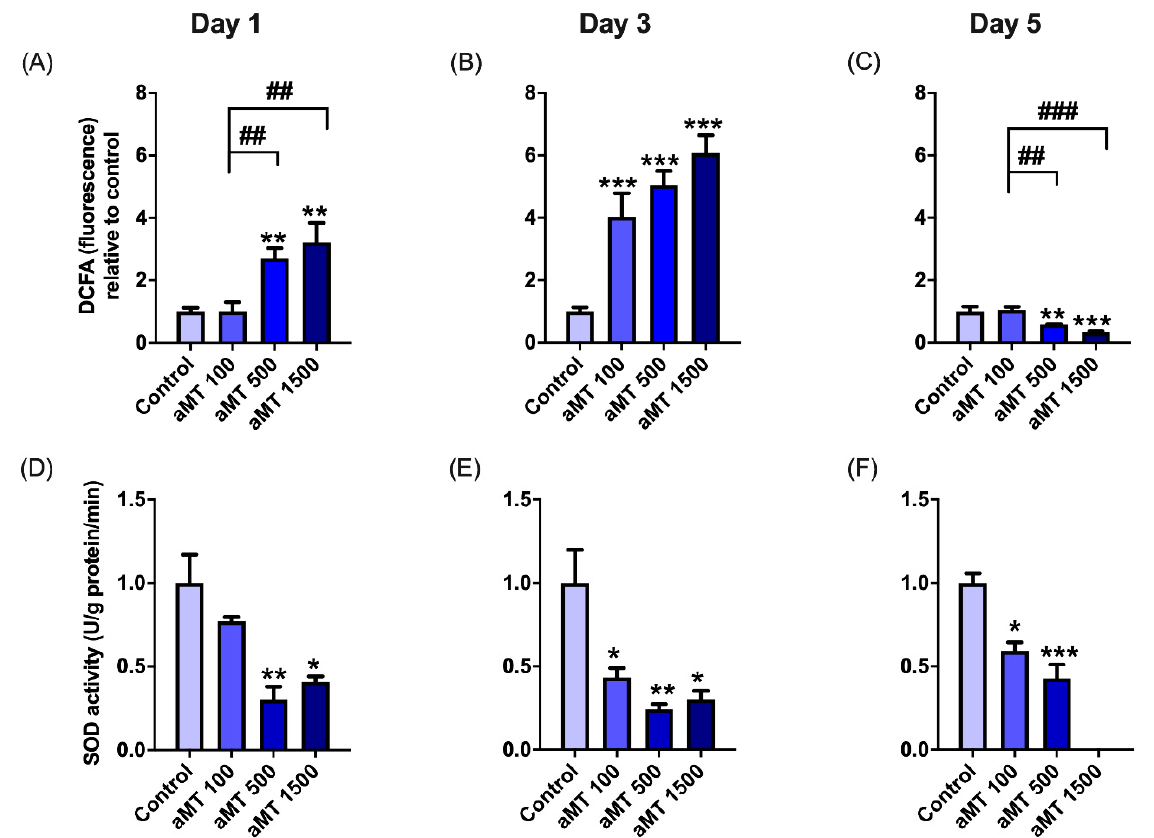
Figure 4. Melatonin-induced oxidative stress in Cal-27 cells. Measurements of intracellular ROS levels by fluorometry after staining with the DCF fluorescent probe ( A – C ) and SOD activity ( D – F ). Data for aMT 1500 group are not shown at day 5 because most cells died. n = 6 per group. Data are presented as mean ± SEM. * p < 0.05, ** p < 0.01, *** p < 0.001 vs. control; ## p < 0.01, ### p < 0.001 vs. aMT 100 µM group.